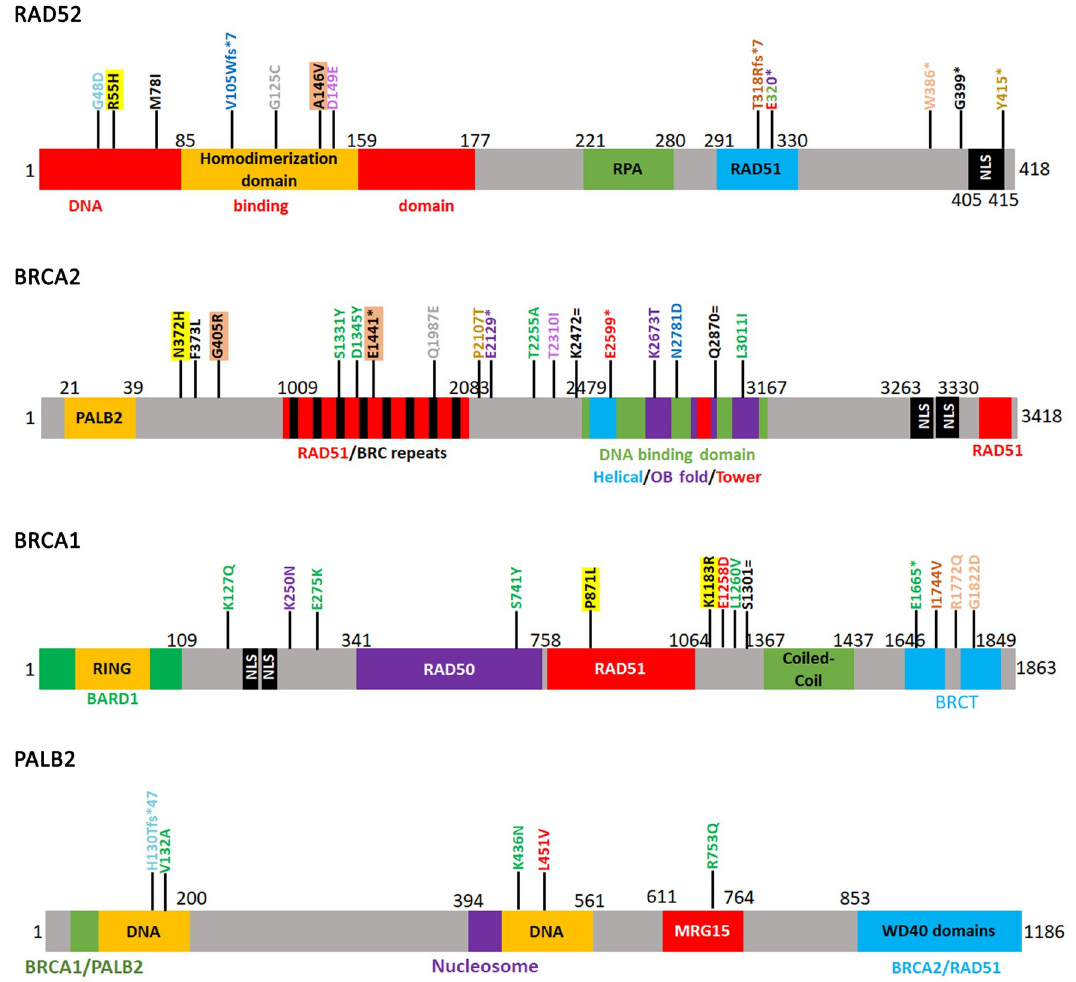
Fig 3. Significant mutations in RAD52, BRCA2, BRCA1 and PALB2. Cartoon diagrams of RAD52, BRCA2, BRCA1 and PALB2 showing specific domains in each gene. The diagrams were adapted from [19, 61–64]. Co-occurring mutations from Table 1 are color coded. Highlighted mutations are those with a high probability of being driver or